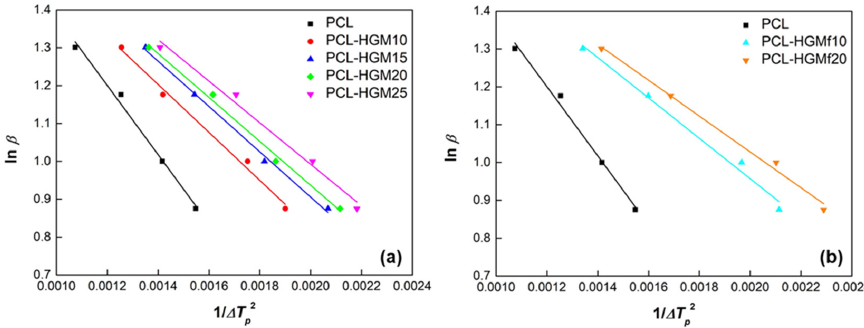
Figure 7. Dobreva plots for PCL and composites PCL-HGM ( a ) and PCL-HGMf ( b ).